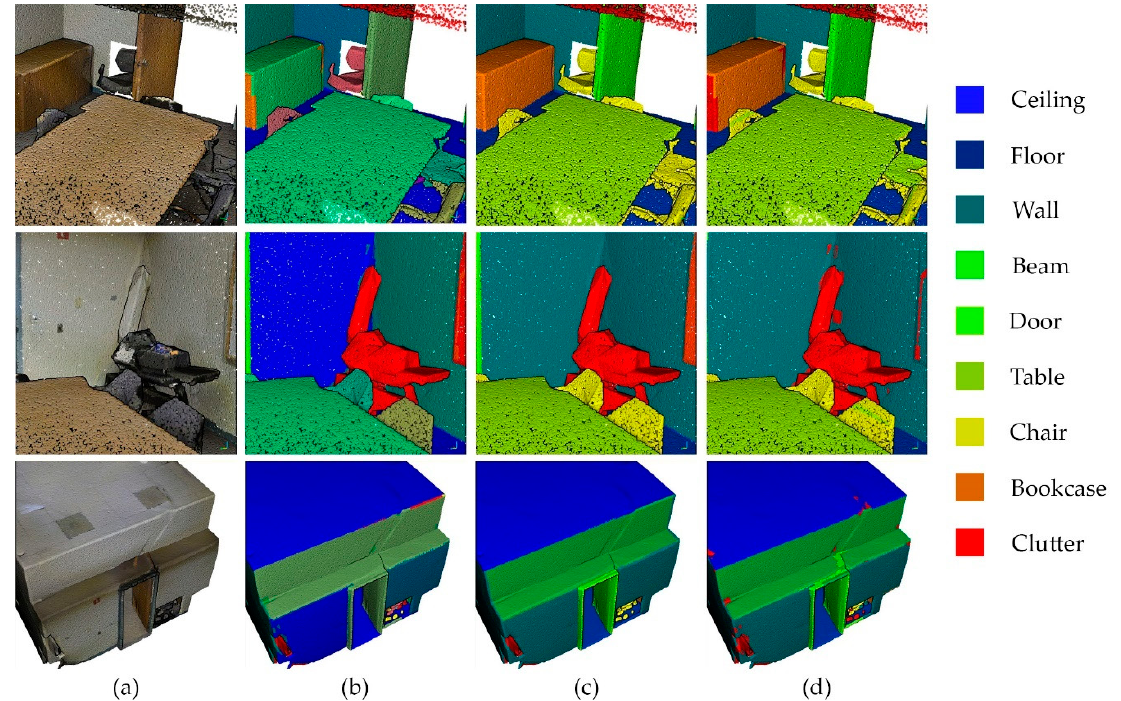
Figure 18: Results of the semantic segmentation on a room sample. ( a ) RGB point cloud, ( b ) Connected Elements, ( c ) Ground Truth, and ( d ) Results of the semantic segmentation.